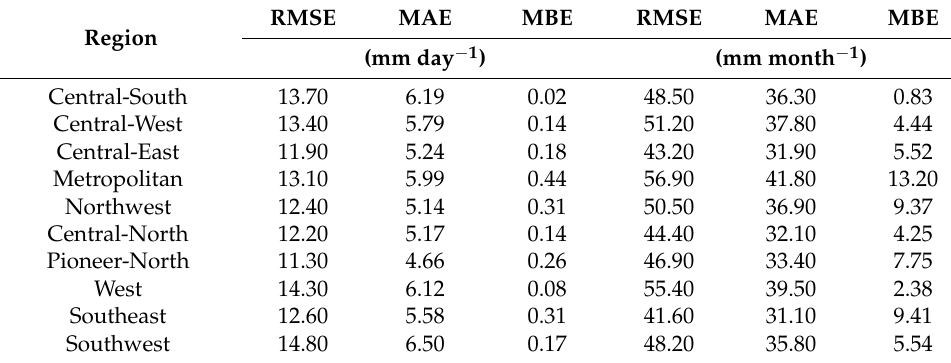
Table 2. Summary of error metrics on a daily and monthly scale of the satellite precipitation products in Paran á regions. The metrics were calculated based on mean areal